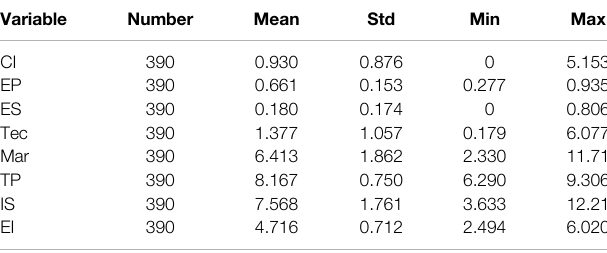
TABLE 2 | Descriptive statistical